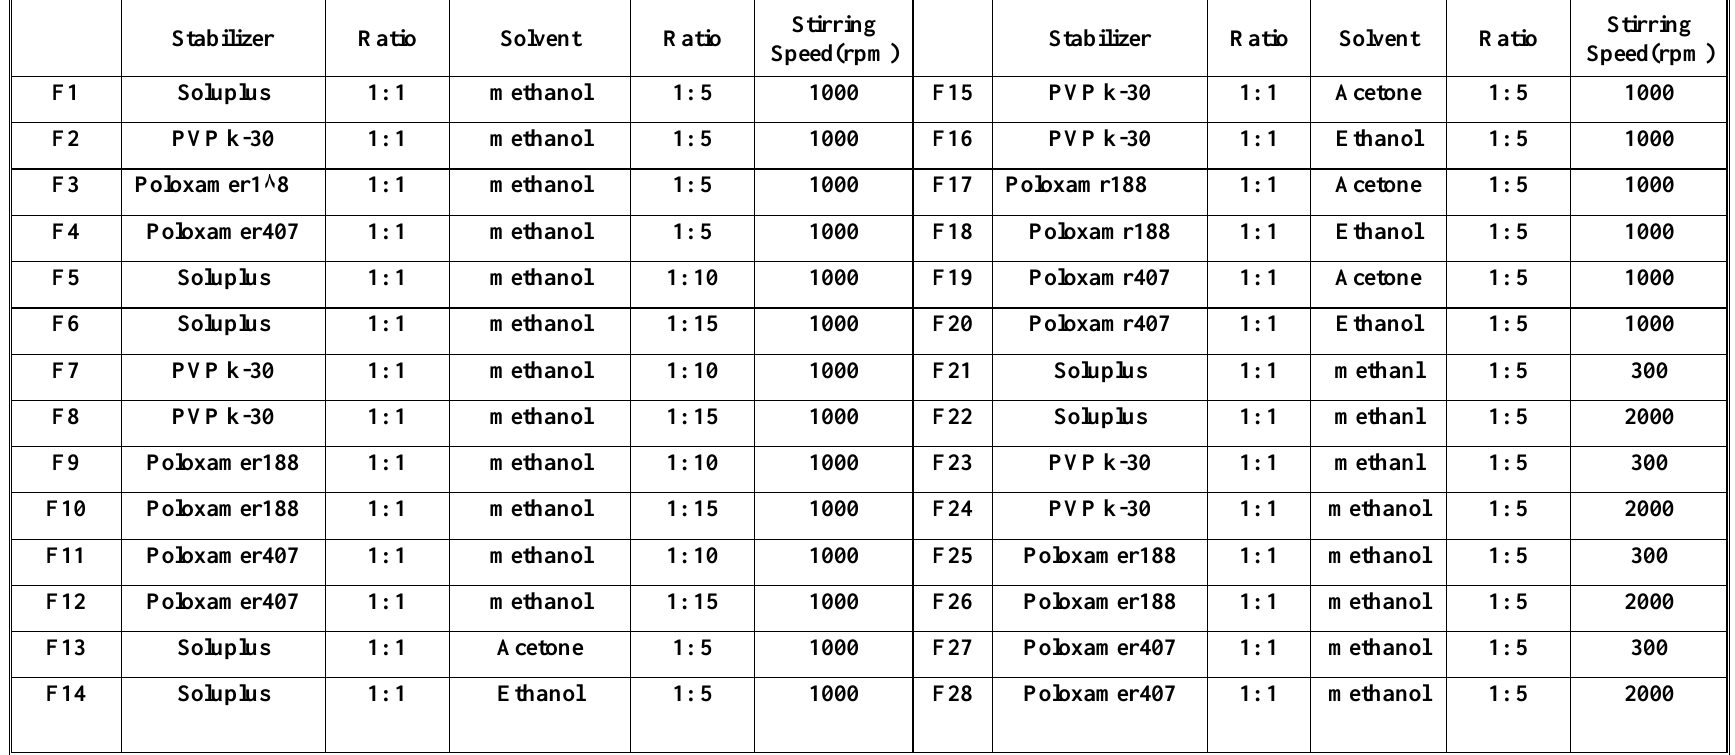
Table 1 .Composition of risperidone nanosuspension using different parameters